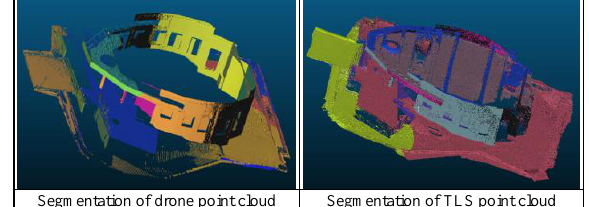
Figure 4 . Segmentation Results